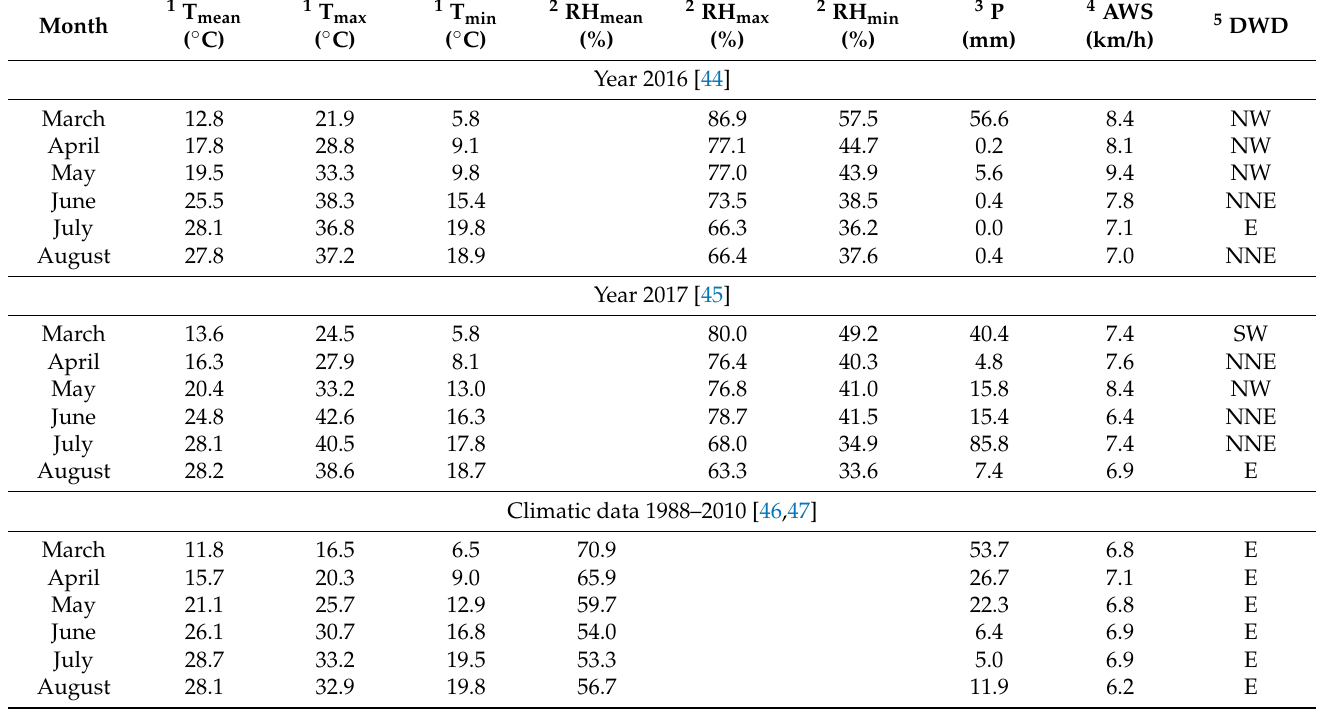
Table 1. Prevailing meteorological conditions in Perigiali, Korinthia, Greece throughout the experi- mental time period (March–August 2016 and March–August 2017). Meteorological and climatic data obtained from the nearest meteorological station (lat. 38 ◦ 00 (cid:48) , long. 22 ◦ 42 (cid:48) alt 15 m; lat. 37 ◦ 58 (cid:48) , long. 22 ◦ 45 (cid:48) , alt 19 m,